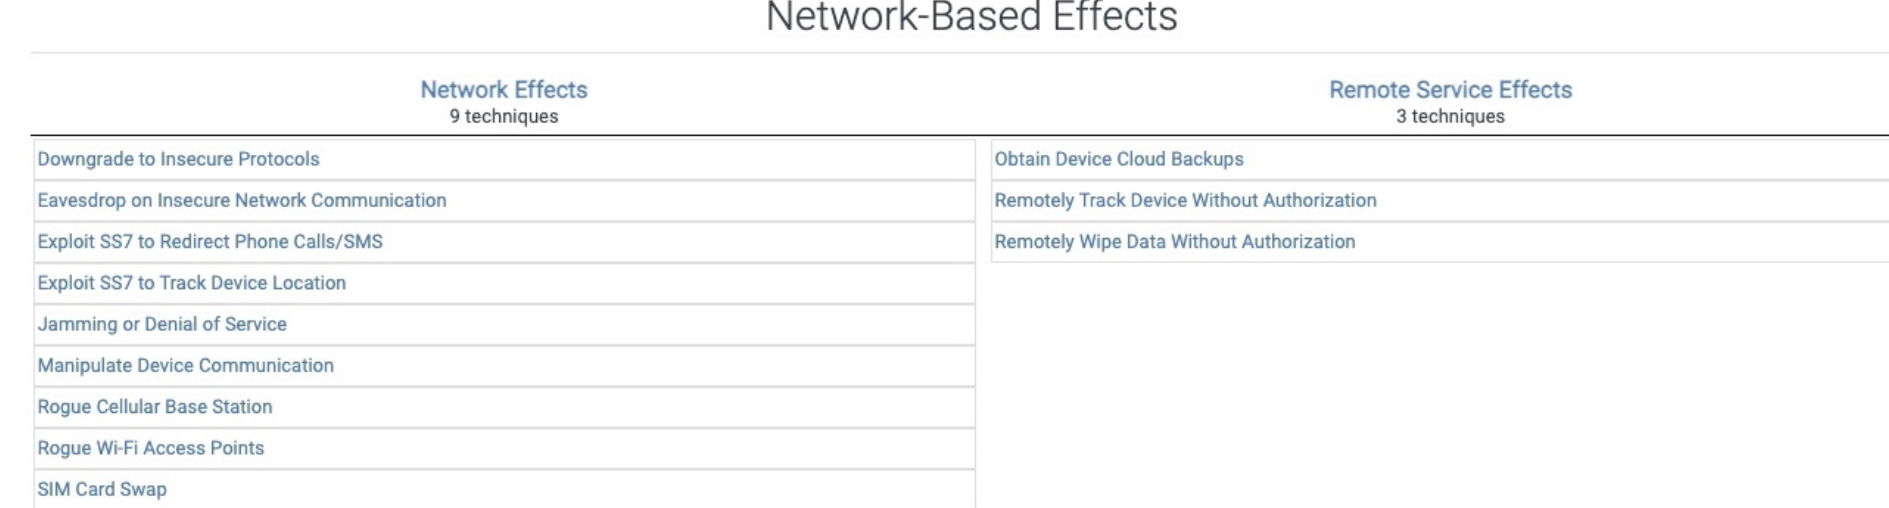
Figure A2. The ATT&CK matrix for the mobile OS consists of two parts. The second part of the matrix covers the network-based